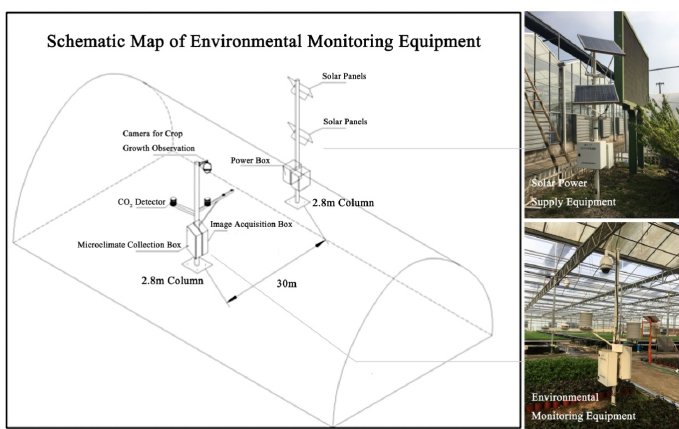
Figure 1. Schematic map of microclimate observation and digital camera in the glass greenhouse.